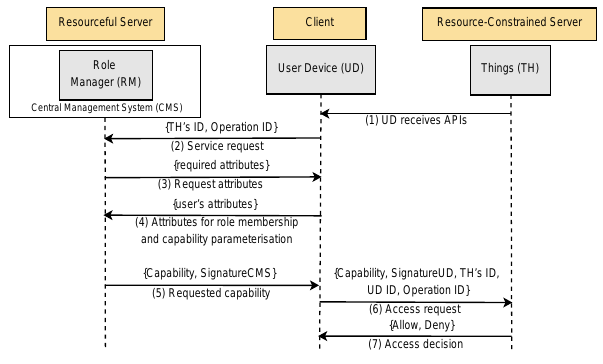
Figure 7. Protocolforserviceaccess.